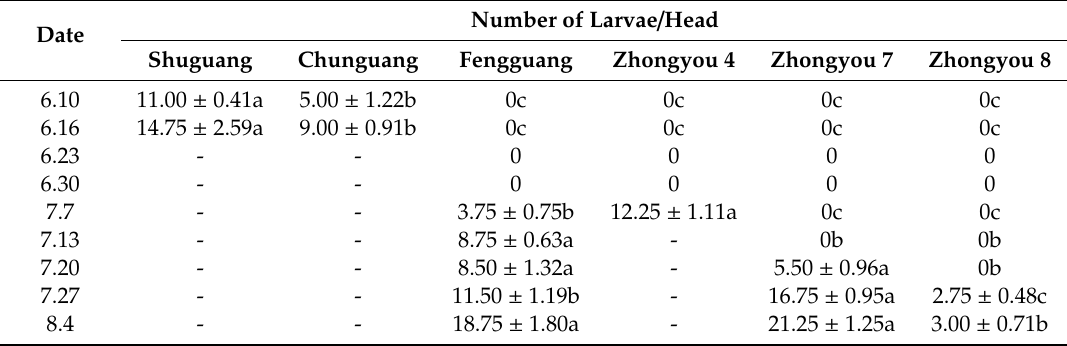
Table 2. The amount of larvae of D. suzukii on intact nectarine varieties on the same collection